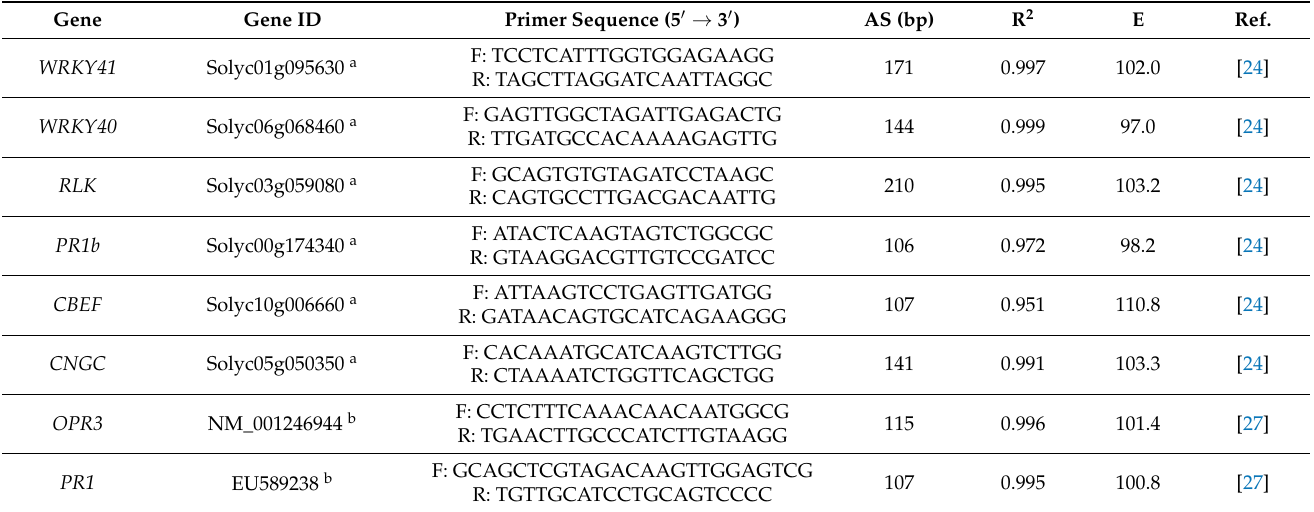
Table 2. Target genes and primers used in